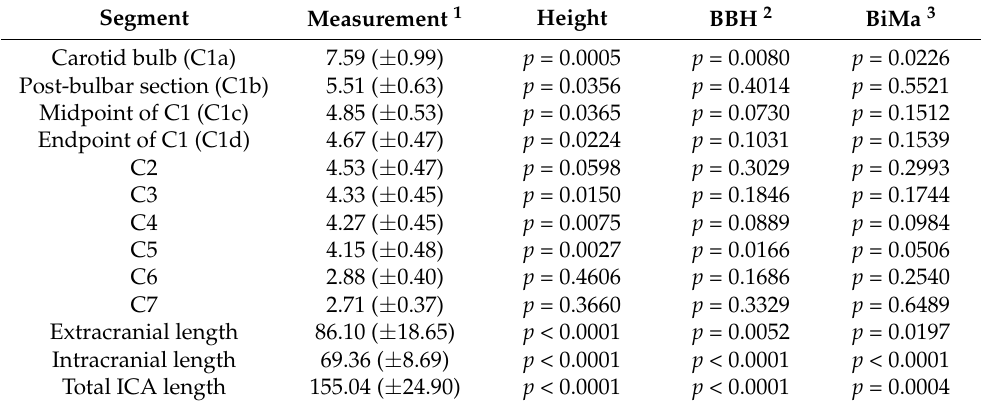
Table 2. Correlations between vessel caliber and length vs. body and cranium size in the study cohort.